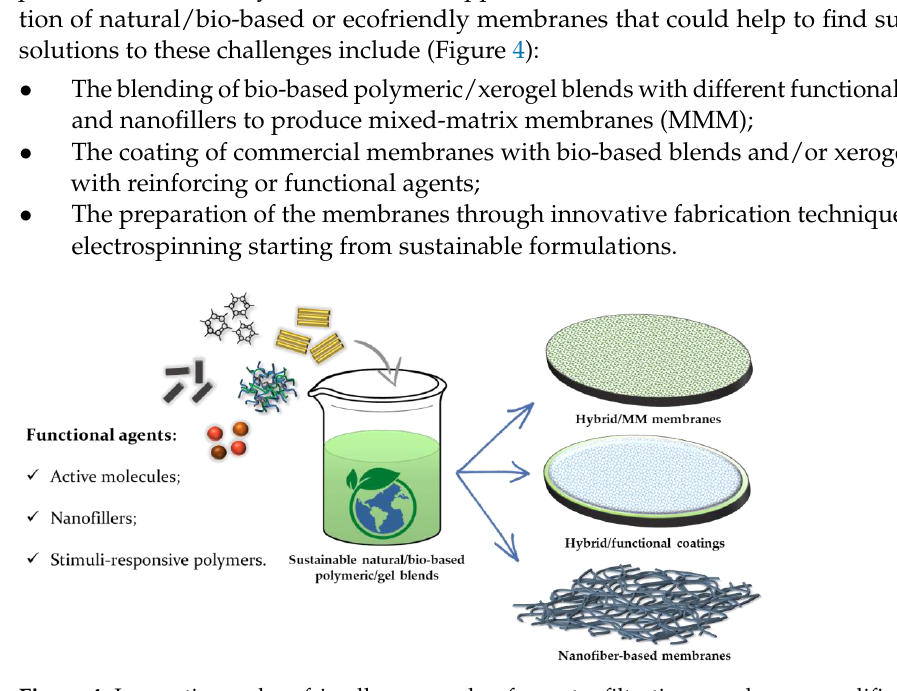
Figure 4. Innovative and ecofriendly approaches for water filtration membranes modification.